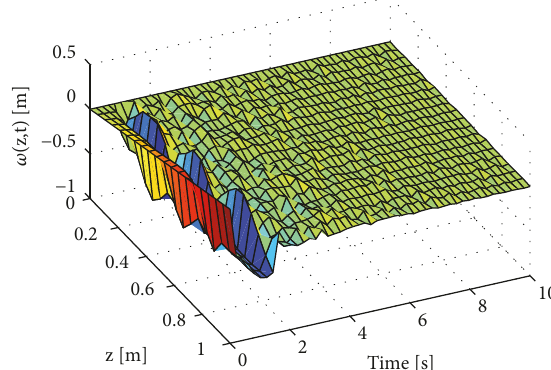
Figure 4: Deflection of the flexible link with proposed control.